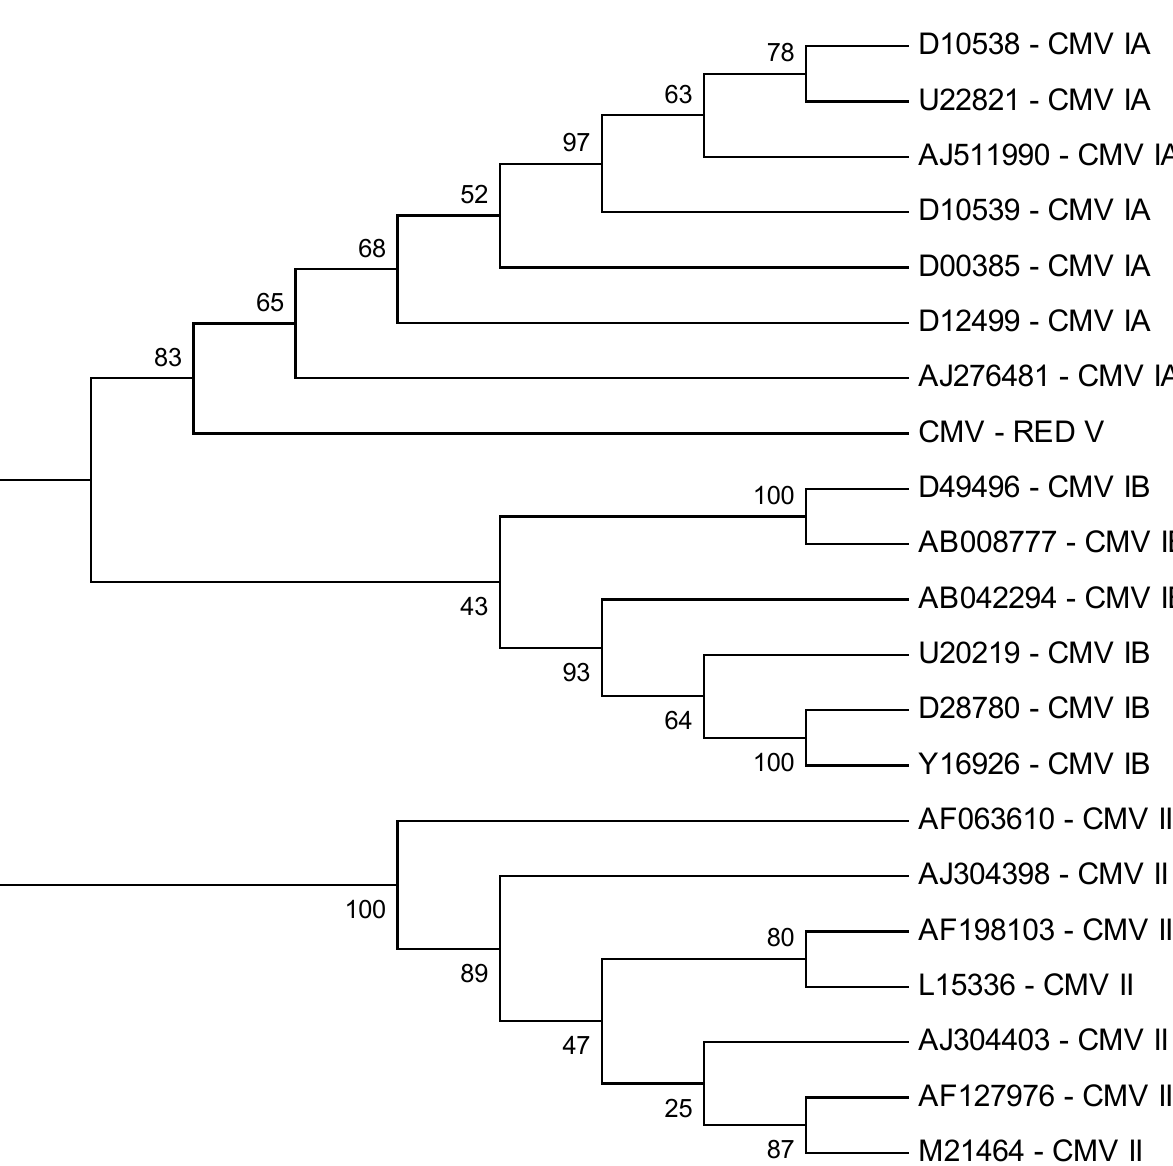
Figure 3. Unrooted phylogenetic tree calculated from a conserved region of the coat protein gene (CP) of CMV species belonging to the three subgroups IA, IB and II. CMV-RED V is the sequence obtained by the